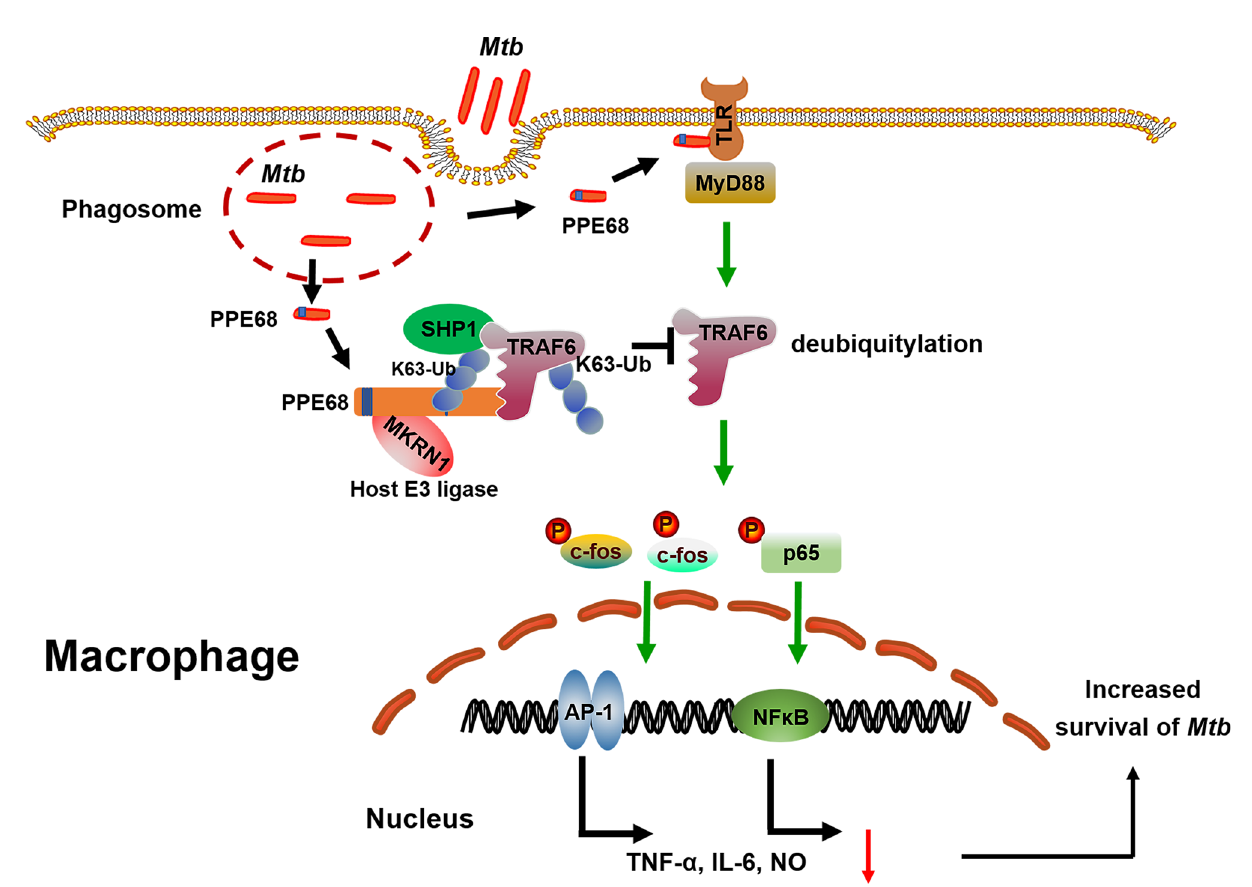
FIGURE 7 | The proposed model of MKRN-1-mediated mycobacterial PPE68 ubiquitination suppressing innate immune responses. PPE68 interacts with MKRN1 and SHP1. Diagram shows the mechanism by which MKRN1-mediated mycobacterial PPE68 K63-linked ubiquitination suppresses host TRAF6 K63 ubiquitination and then inhibits TLR2-MyD88-TRAF6-driven NF- k B and AP-1 in fl ammatory innate immune responses via SHP1 and promotes Mtb